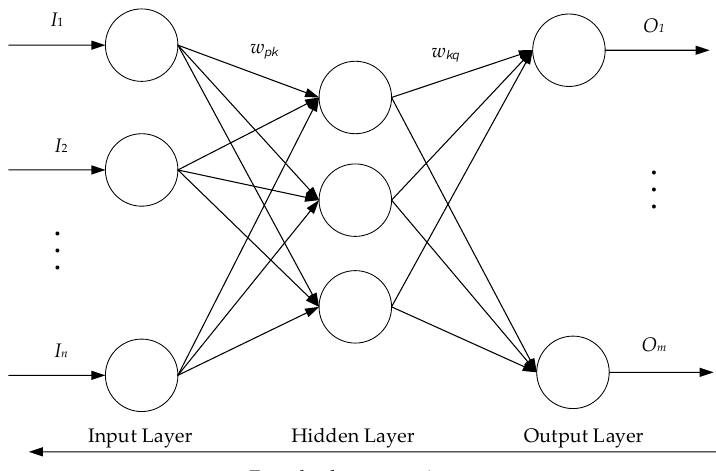
Figure 5. Structure of BP neural network.